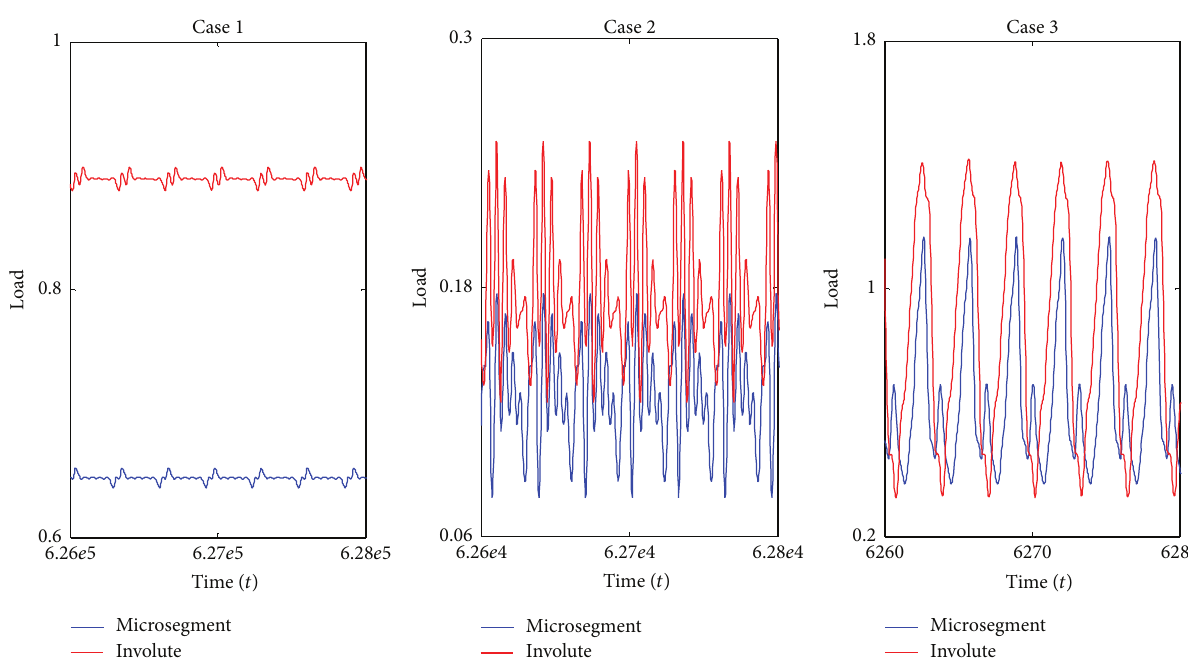
Figure 10: Dimensionless dynamic meshing loads for three